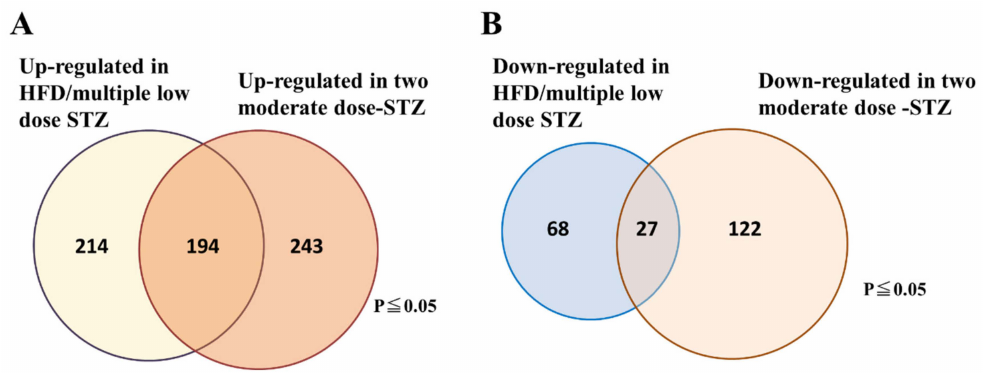
Figure 1. Venn diagram showing the number of genes that are significantly altered in the kidney tissues of the two STZ-induced DN models. ( A ) Number of upregulated genes. ( B ) Number of down- regulated genes. The data are representative of two independent experiments (i.e., HFD/multiple